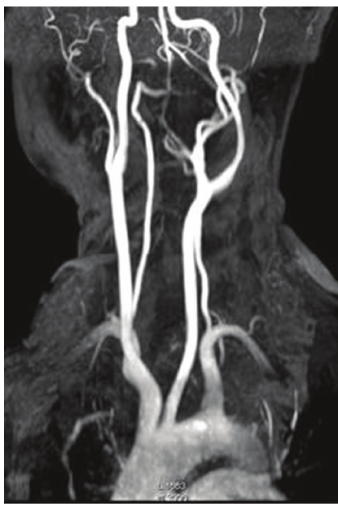
Figure 6: MR angiography image is showing splaying of external and internal carotid vessels on the left side.